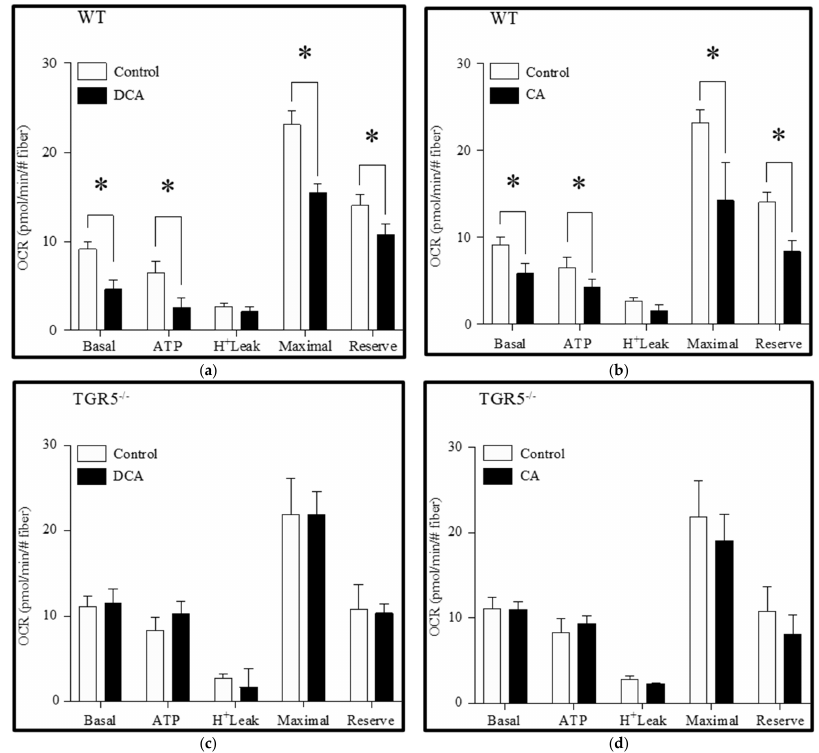
Figure 4. Deoxycholic acid (DCA) and cholic acid (CA) decrease the oxygen consumption rate (OCR) in muscle fiber through a TGR5-dependent mechanism. Skeletal muscle fibers from WT and TGR5 − / − mice were incubated with DCA or CA for 72 h, and the basal, ATP-linked, H + -leak, maximal, and spare OCR were determined as described in the Materials and Methods section. (a,b) Analysis for OCR in WT fibers incubated with DCA ( a ) or CA ( b ). ( c , d ) Analysis for OCR in TGR5 − / − fibers incubated with DCA ( c ) or CA ( d ). Values correspond to the mean ± SEM ( n = 3, * p < 0.05, t -test).